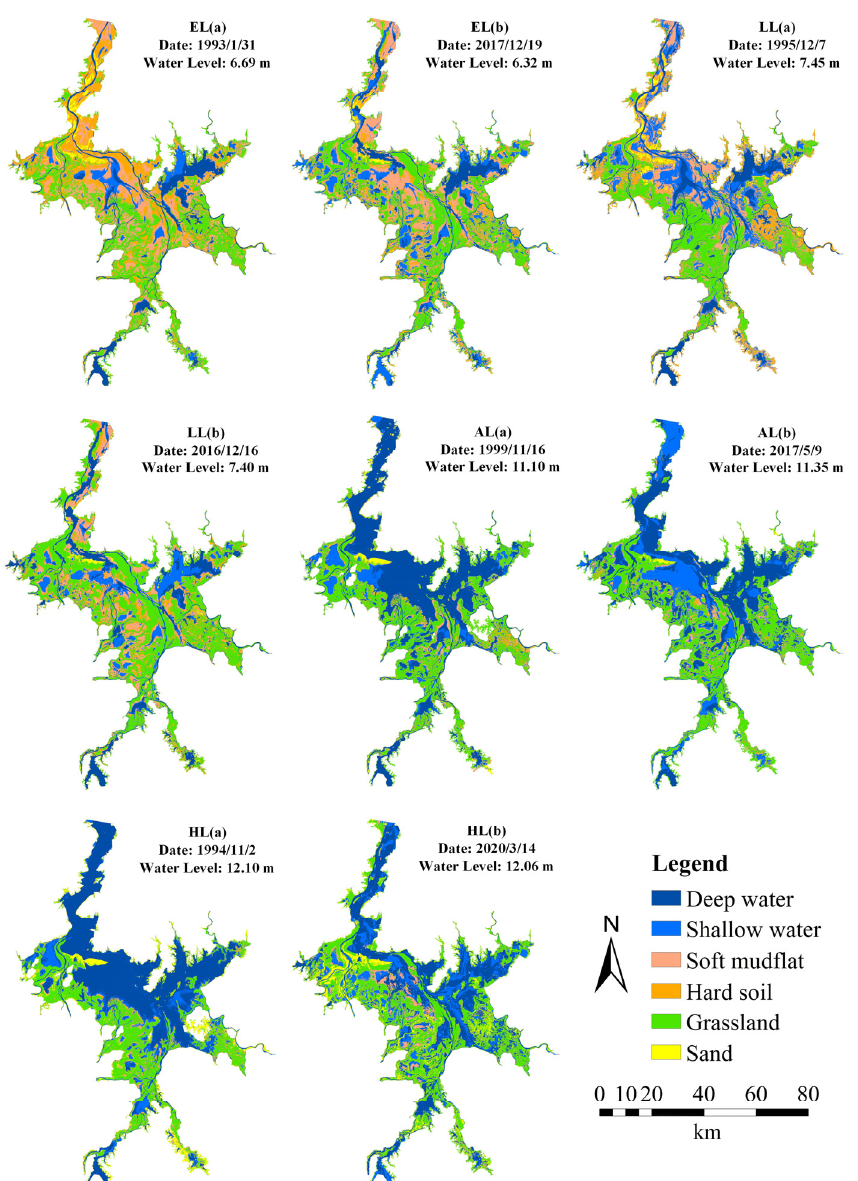
Figure 2. Poyang Lake wetland landscapes with various water levels (EL: extremely low level; LL: low level; AL: average level; HL: high level). See Figures S1–S4 for the detailed landscapes within all water level intervals.